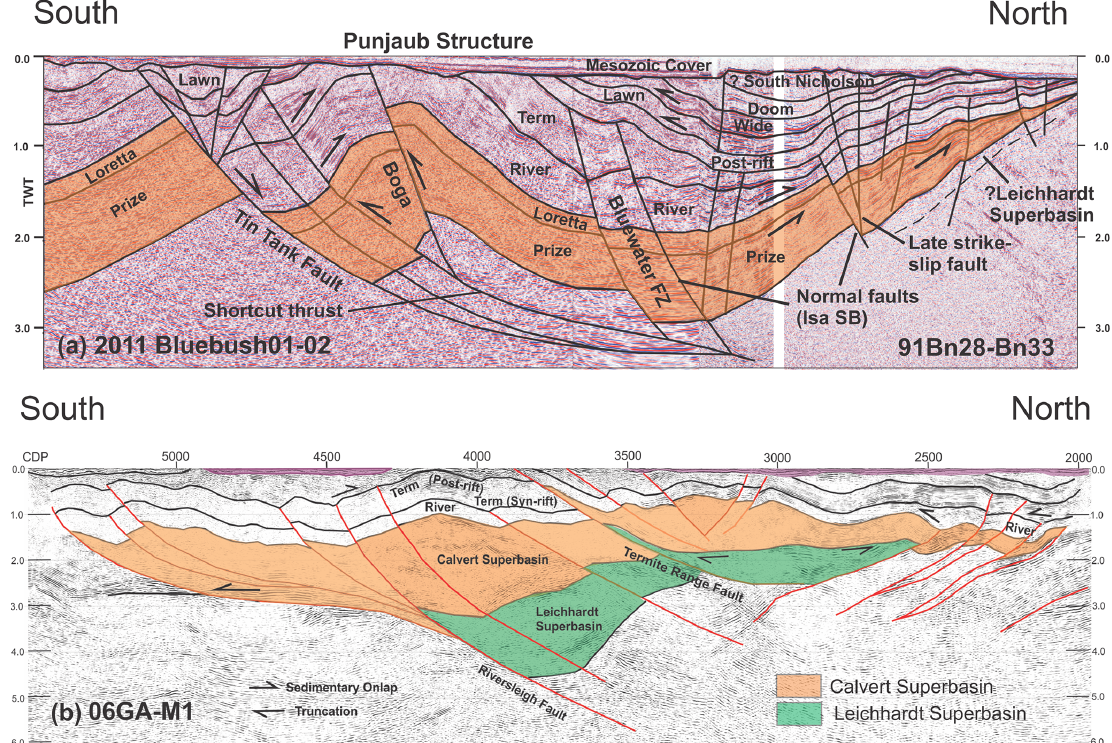
Figure 6. North–south-oriented transect across Lawn Hill Platform made up of selected industry and government seismic sections (Fig. 5) showing the predominance of north-dipping normal faults on which there have been successive episodes of basin inversion, leaving behind a legacy of fault reactivation and periclinal folding in (a) Punjaub Structure and (b) Mount Caroline and Ploughed Mountain (after Gibson et al., 2017, 2020). Note the thinning of River and Term supersequences northward through onlap in (a) ; the underlying Loretta Supersequence similarly thins northward but is bounded top and bottom by truncated surfaces thought to reflect considerable loss of stratigraphic section by uplift and erosion accompanying the 1650–1640Ma Riversleigh Tectonic Event. Sedimentary patterns point to growth faulting on north- dipping structures during the deposition of the Isa, but not underlying the Calvert Superbasin, whose sequences are merely offset. Bluewater, Boga, and Tin Tank Fault names adopted from Bradshaw et al. (2018) and unpublished industry maps (Pursuit Minerals, 2017). In (b) the older sequence had already been folded before the River Supersequence was deposited as evidenced by the thinning of the latter over the crests of folds developed in the Calvert Superbasin at deeper levels beneath Mount Caroline. The Calvert Superbasin is, in turn, separated by an angular unconformity from an even older underlying sequence inferred (Gibson et al., 2017, 2016) to be the Leichhardt Superbasin. Colour coding is the same as Fig. 3. TWT: two-way time (in seconds; 1s approximately equals 3km